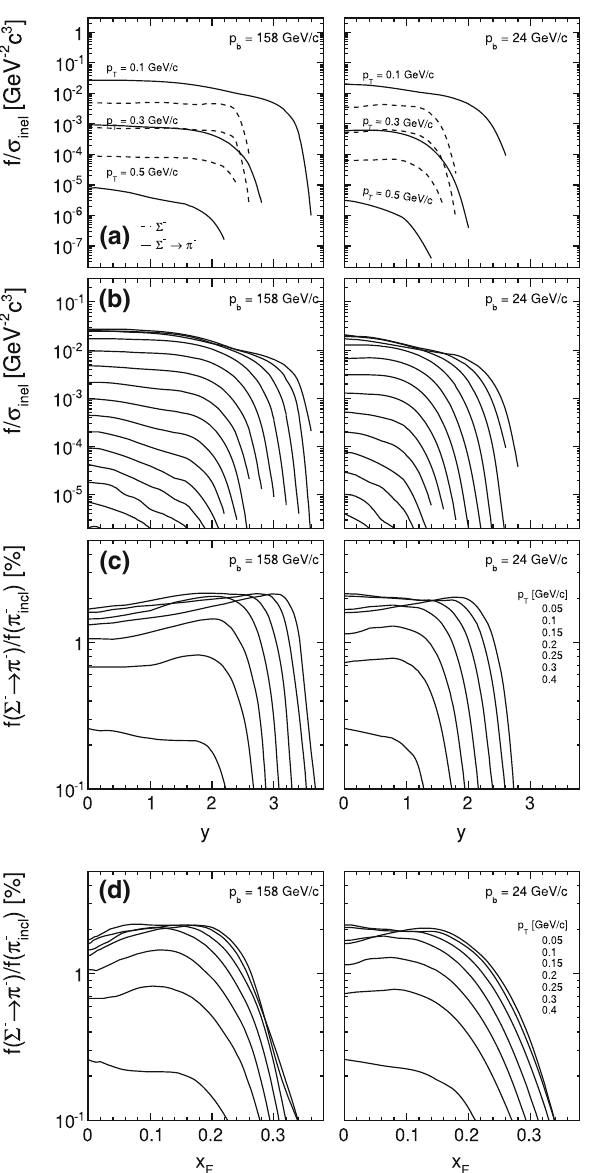
Fig. 23 a Invariant π − cross section f /σ inel from Σ − decay as a func- tion of y for four values of p T at 158 and 24 GeV/c beam momentum. Full lines for decay π − and broken lines for the parent Λ . Subsequent p T values are multiplied by 1/5 for clarity; b invariant π − cross section f /σ inel from Σ − decay as a function of rapidity for p T between 0.05 and 1.3 GeV/c; c percentage ratio of the total π − from Σ − decay to the inclusive, feed-down subtracted π − yield; d Same as c but as a function of x F